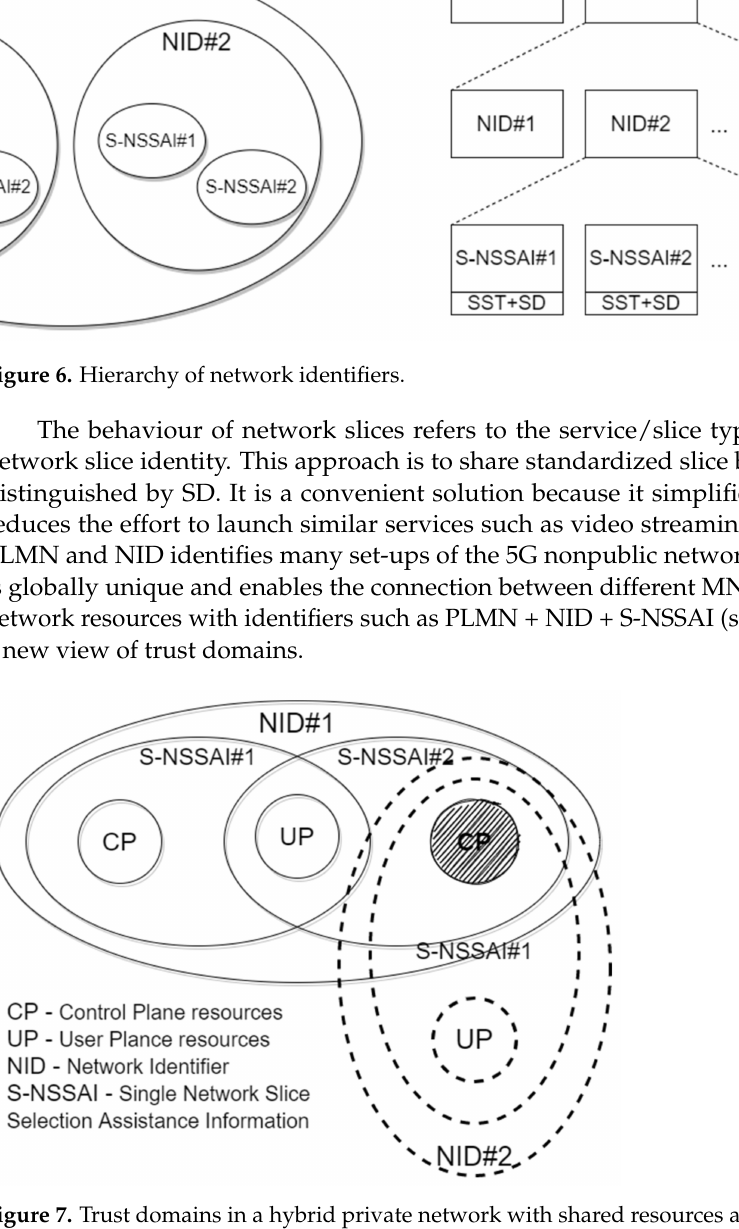
Figure 7. Trust domains in a hybrid private network with shared resources and network